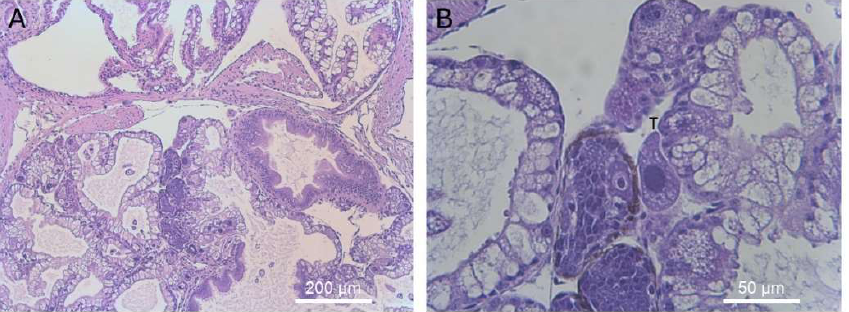
Figure 11. Histological section of reproductive organs showing a single ciliate adjacent to the devel- oping gonad. Magnification ×40 ( A ) and ×400 ( B ). Ciliates are marked with a “T” above the cell in panel B.